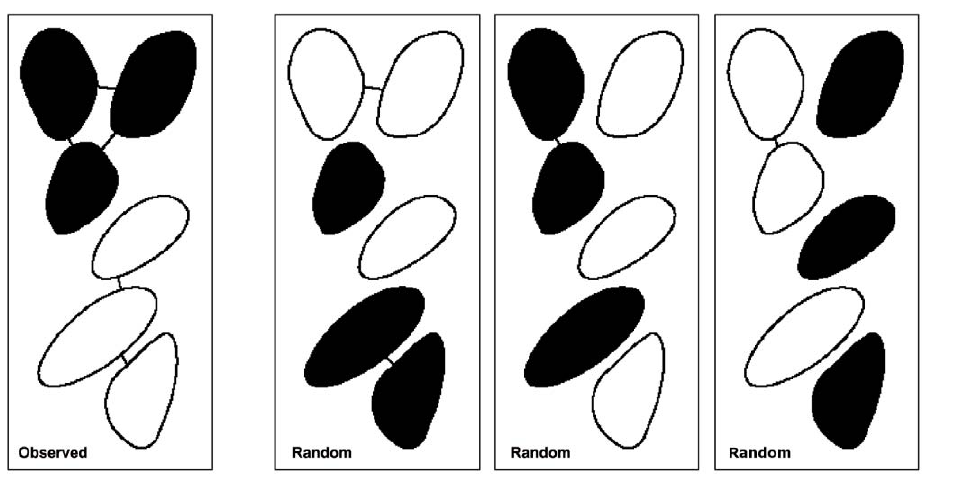
Figure 1. Simplified illustration of Monte-Carlo approach. Hypothetical configuration (observed; randomized) showing aggregations of two species (black/white). Neighbouring conspecifics are joined by arcs. Our measure of the degree of conspecific aggregation equals the number of arcs in the frame (i.e. 5 in frame 1). Frames 2-4: Sample random reconfigurations of the species labels, the number of arcs being 2, 1 and 1.